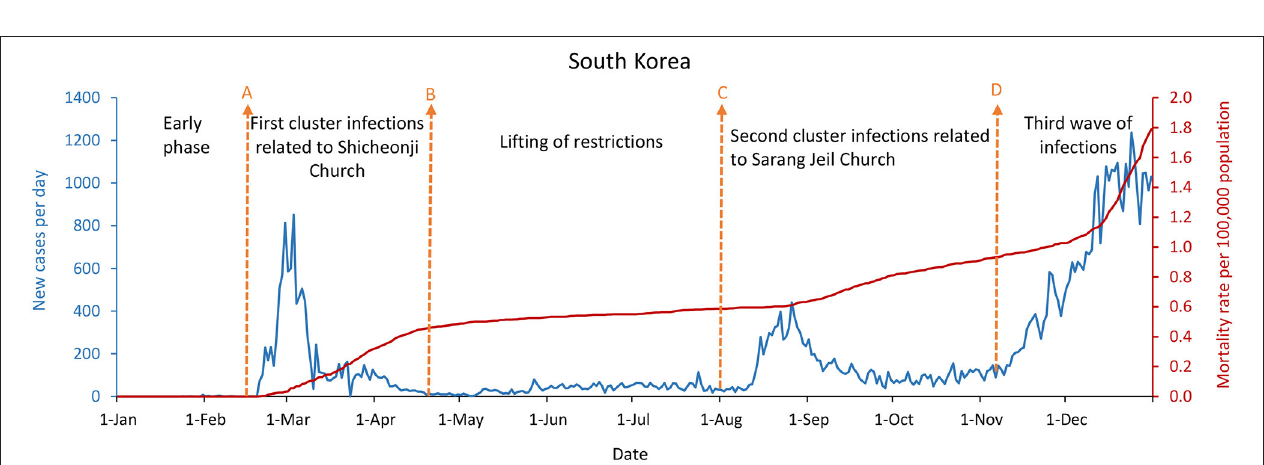
FIGURE 2 | South Korea’s COVID-19 epidemic curves and population mortality rate (between January 1 and December 31, 2020). (A) Starting on February 19, 2020, canceling mass gatherings, and various measures were taken to mass testing. (B) Starting on April 22, lifting restrictions of stores, restaurants, gyms, cram schools, bars, and religious services. (C) Starting in August, authorities ordered 12 high-risk business categories, including nightclubs, karaoke bars, buffet restaurants, and museums to cease operations; banned gatherings; imposed distancing rules; and wearing masks continued to be in place. (D) Starting on November 9, escalating the social distancing